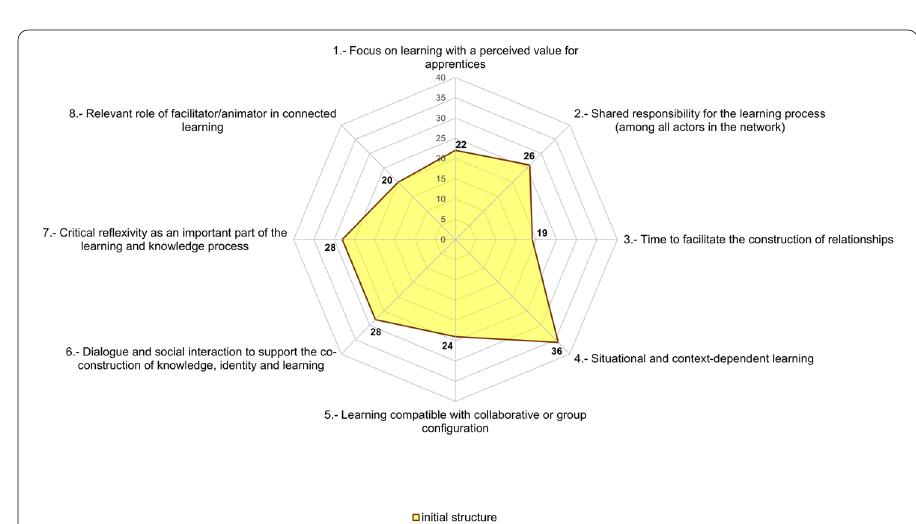
Fig. 2 Guiding structure for global observation of NLP in ADS. The NLP score corresponds to the value obtained from the observation guide matrix (Additional file 2: Appendix 2), with a maximum score of